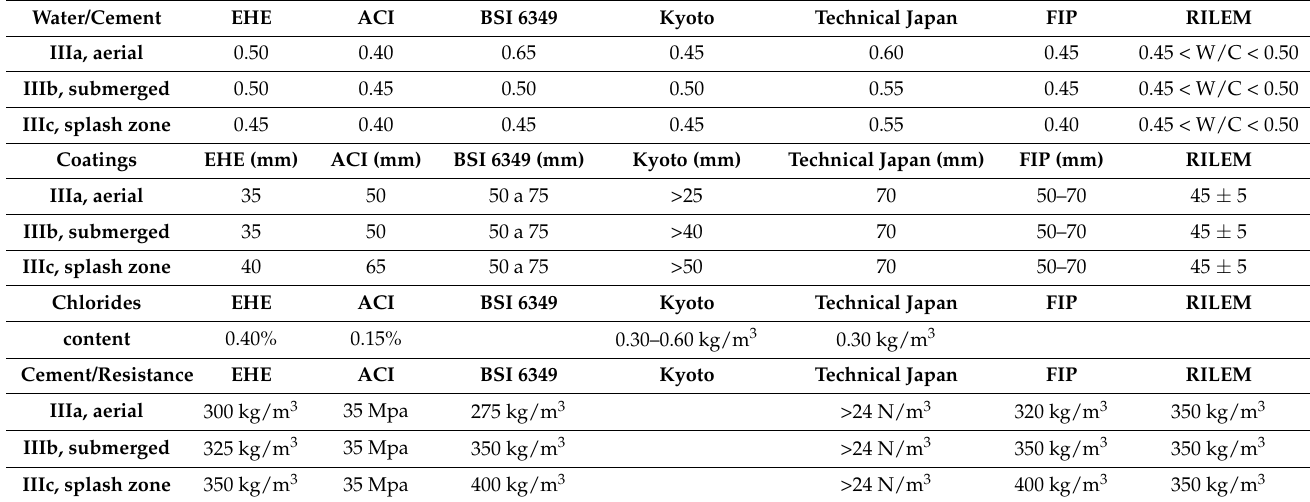
Table 1. Basic properties of reinforced concrete in aggressive marine environments. Source: Own elaboration.